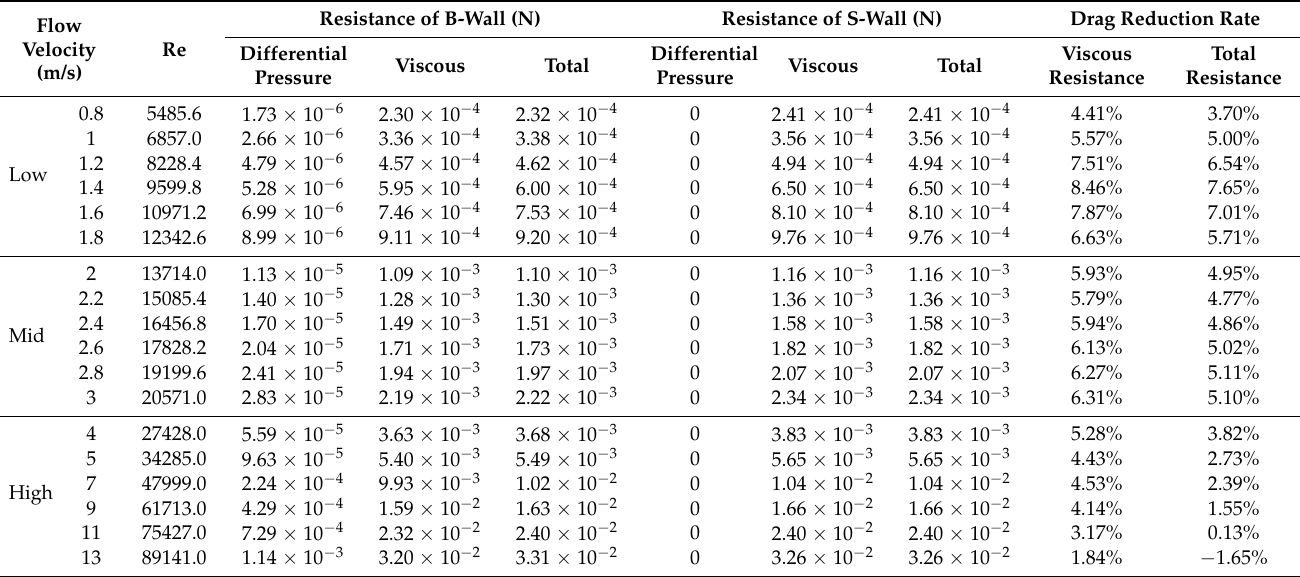
Table 4. Drag reduction rate under different flow